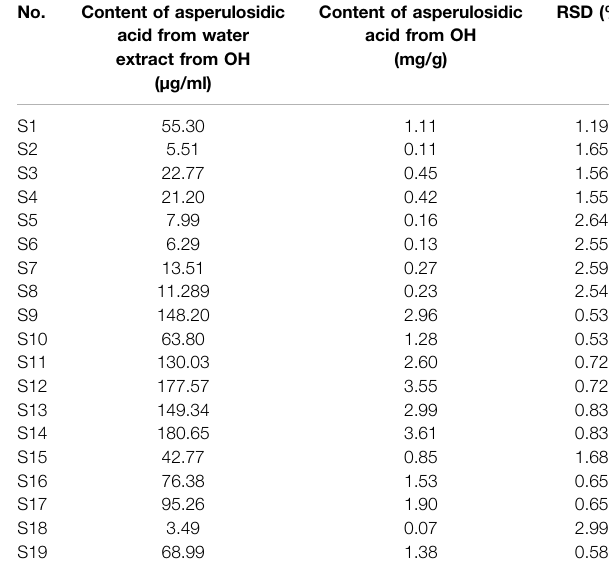
TABLE 7 | The analysis of the asperulosidic acid from Oldenlandia hedyotidea (DC.)